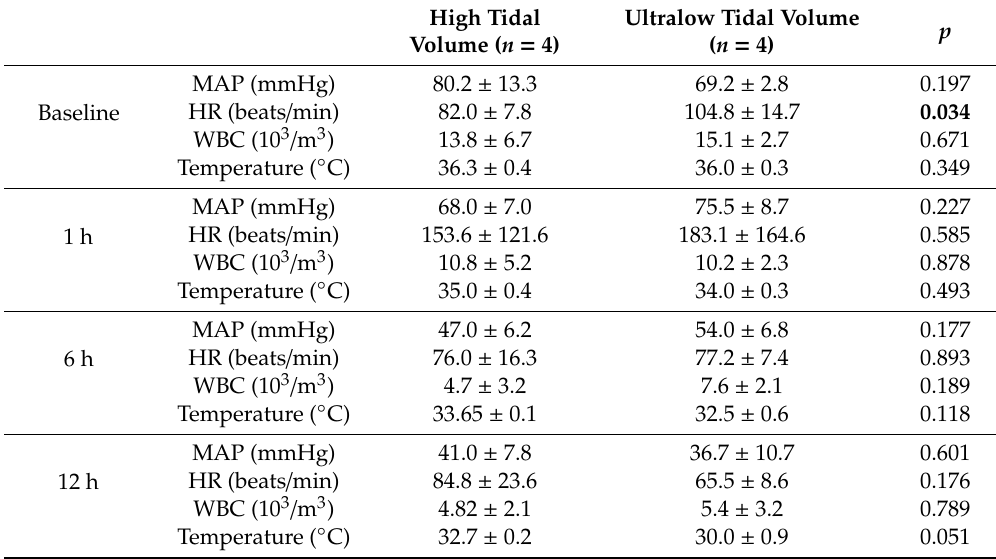
Table 1. Vital sign and laboratory